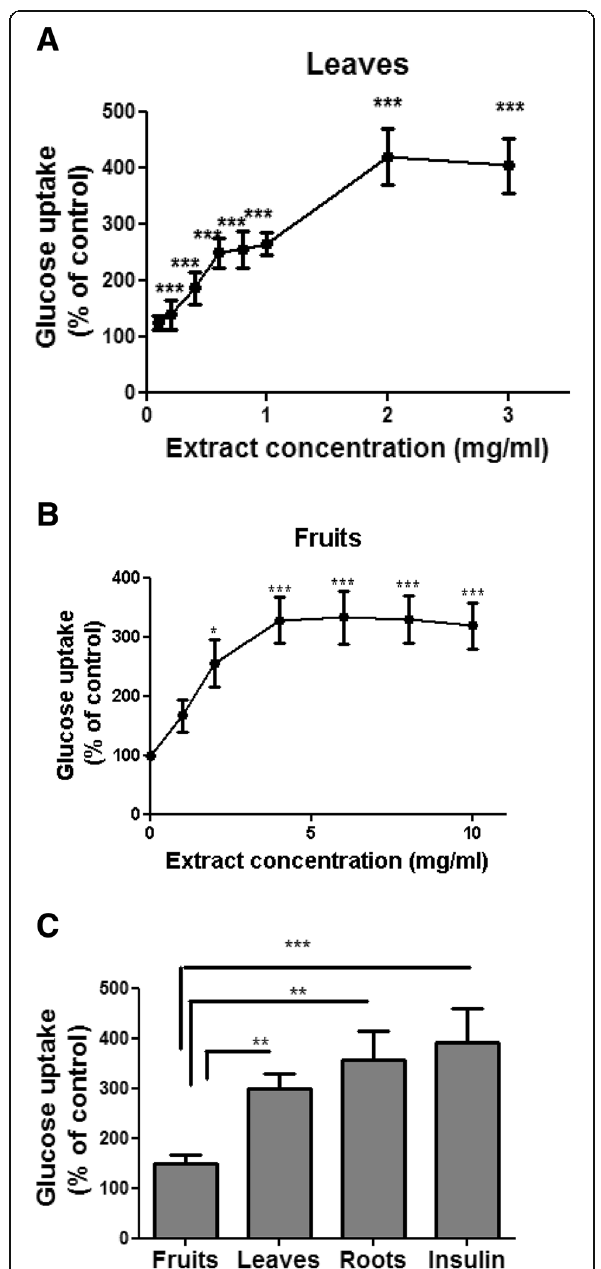
Fig. 4 S. spinosum root extract is more effective than leaves or fruits extract in the induction of glucose uptake. Differentiated 3 T3-L1 adipocytes were treated with leaves a or fruits b S. spinosum extracts at various concentrations or all at 1 mg/ml, with the use of roots extract and insulin (100 nM) as positive control c for 30 min. The uptake of [3H]2-Deoxy-D-glucose into cells was determined as described in Material and Methods . Data are expressed as percent of basal uptake in control cells. The data represents the Mean ± SEM of measurement made on 3 replicates in each of at least 5 independent experiments. * p < 0.05, ** p < 0.005, *** p < 0.0005 compared to untreated cells by Student ’ s t